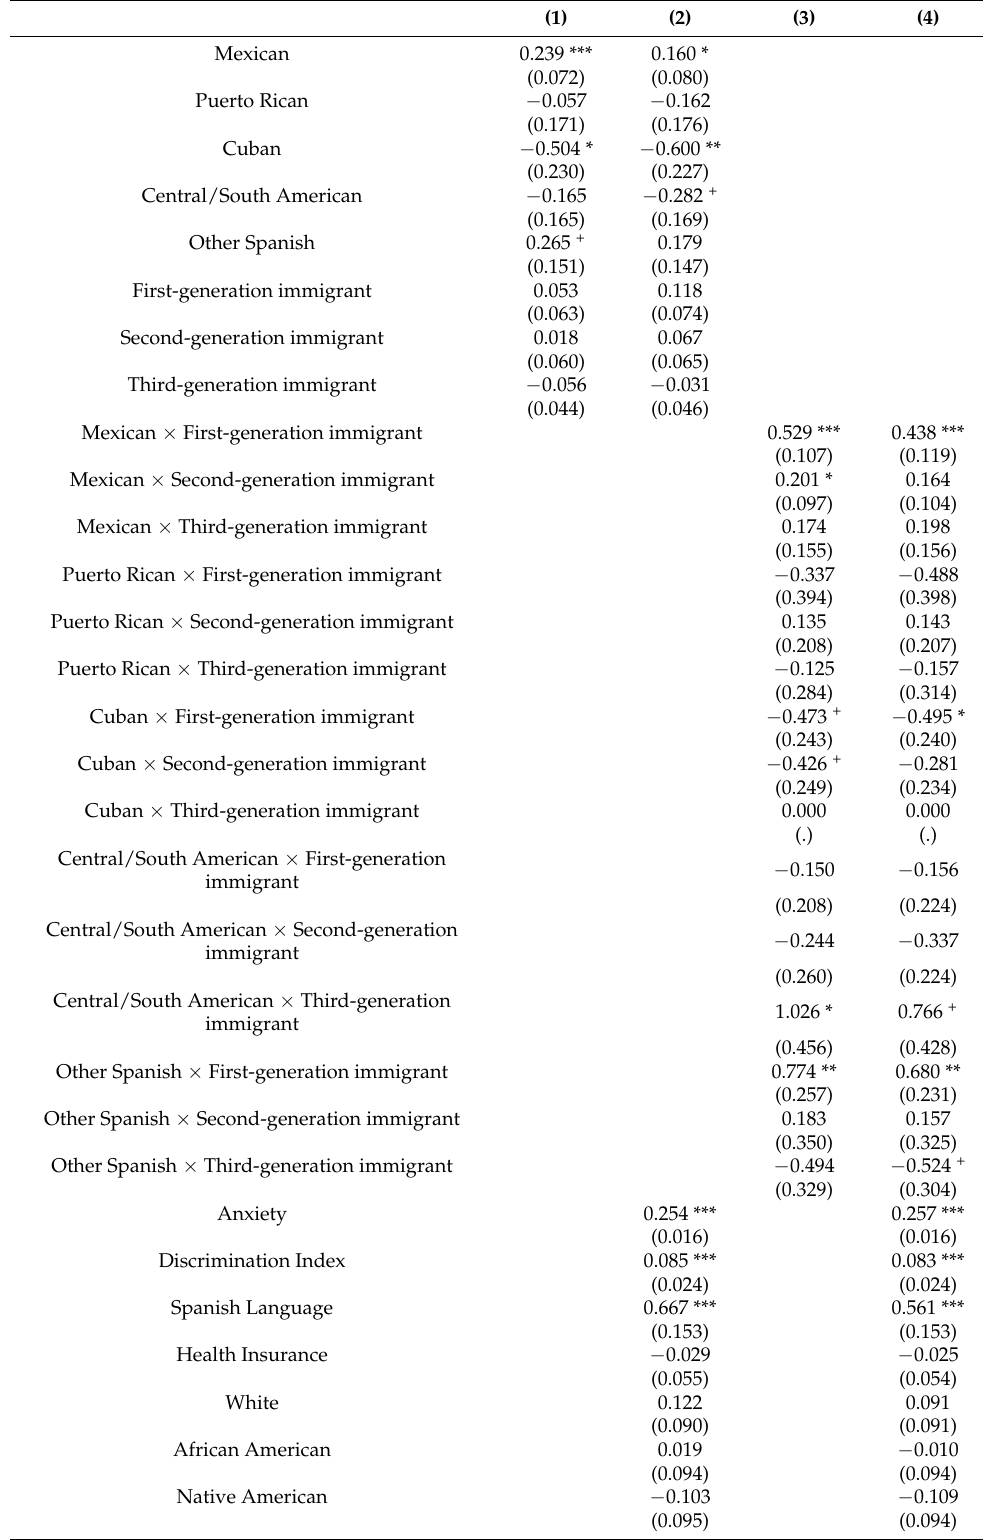
Table 3. Perceived Risk of Infection, by